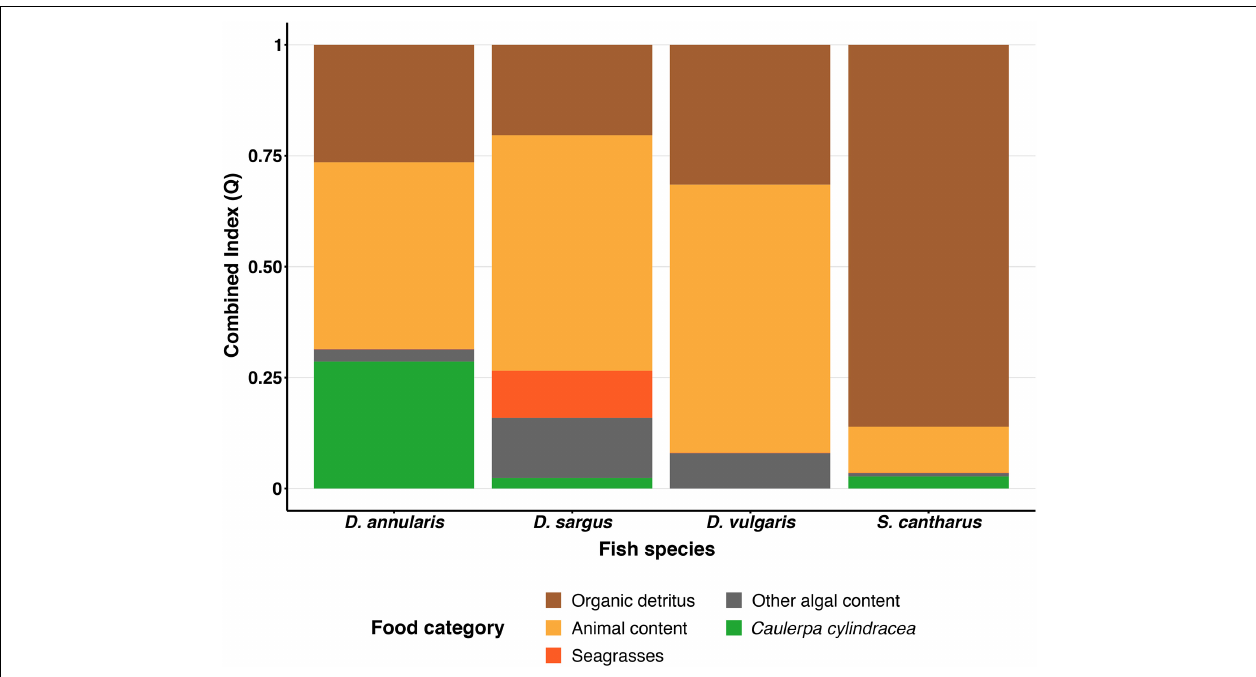
FIGURE 1 | Combined Index (Q) for each fish species. Each color represents one of five food categories (Organic detritus, Animals, Seagrasses, Other algae and Caulerpa